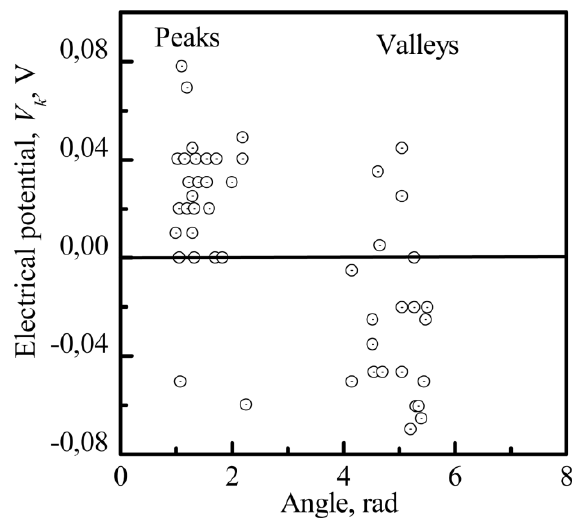
Figure 16. The distribution of the EP of the CP surface ( V k ) versus the vertexes and interior angles of the CP nanorelief.